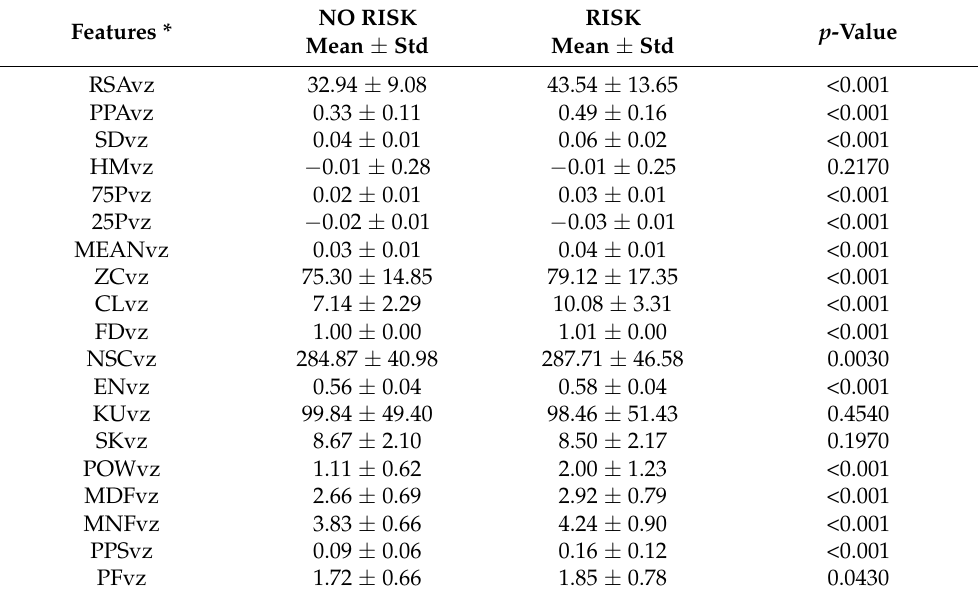
Table 9. Paired t -test NO RISK/RISK classes for each feature extracted from z -axis angular velocity (vz). Features